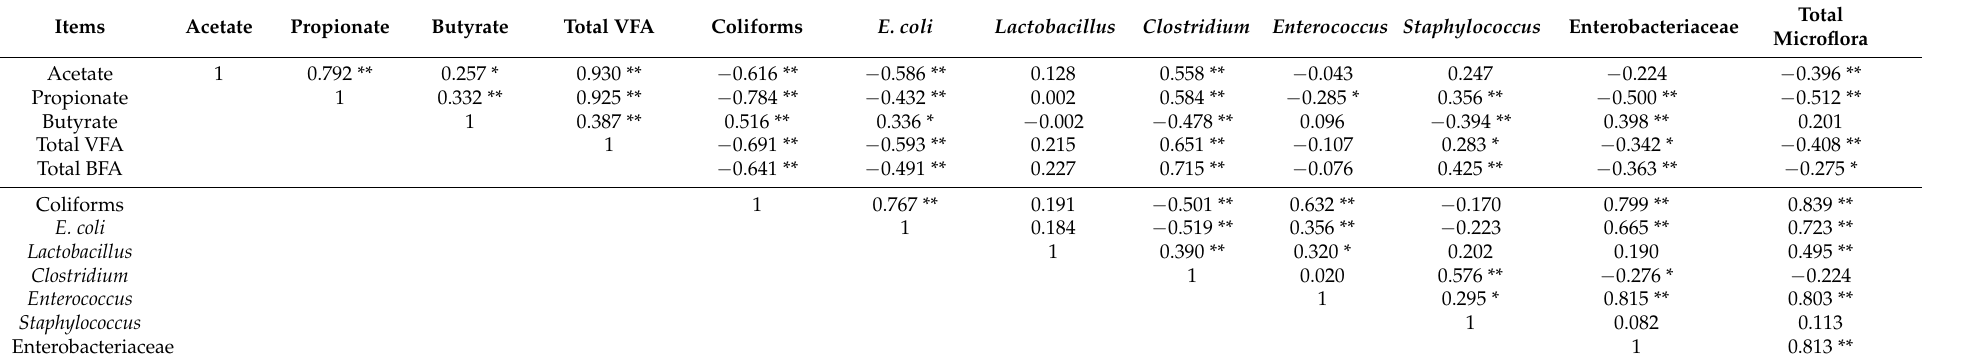
Table 8. Spearman correlation coefficients between main VFAs ( µ mol/g) and microflora (log 10